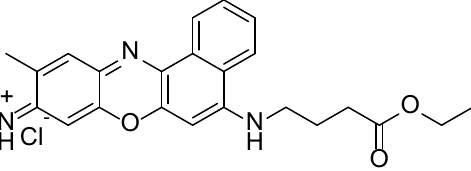
Figure 1. Chemical structure of N -(5-((4-ethoxy-4-oxobutyl)amino)-10-methyl-9 H -benzo[ a ]phenox- azin-9-ylidene)ethanaminium chloride